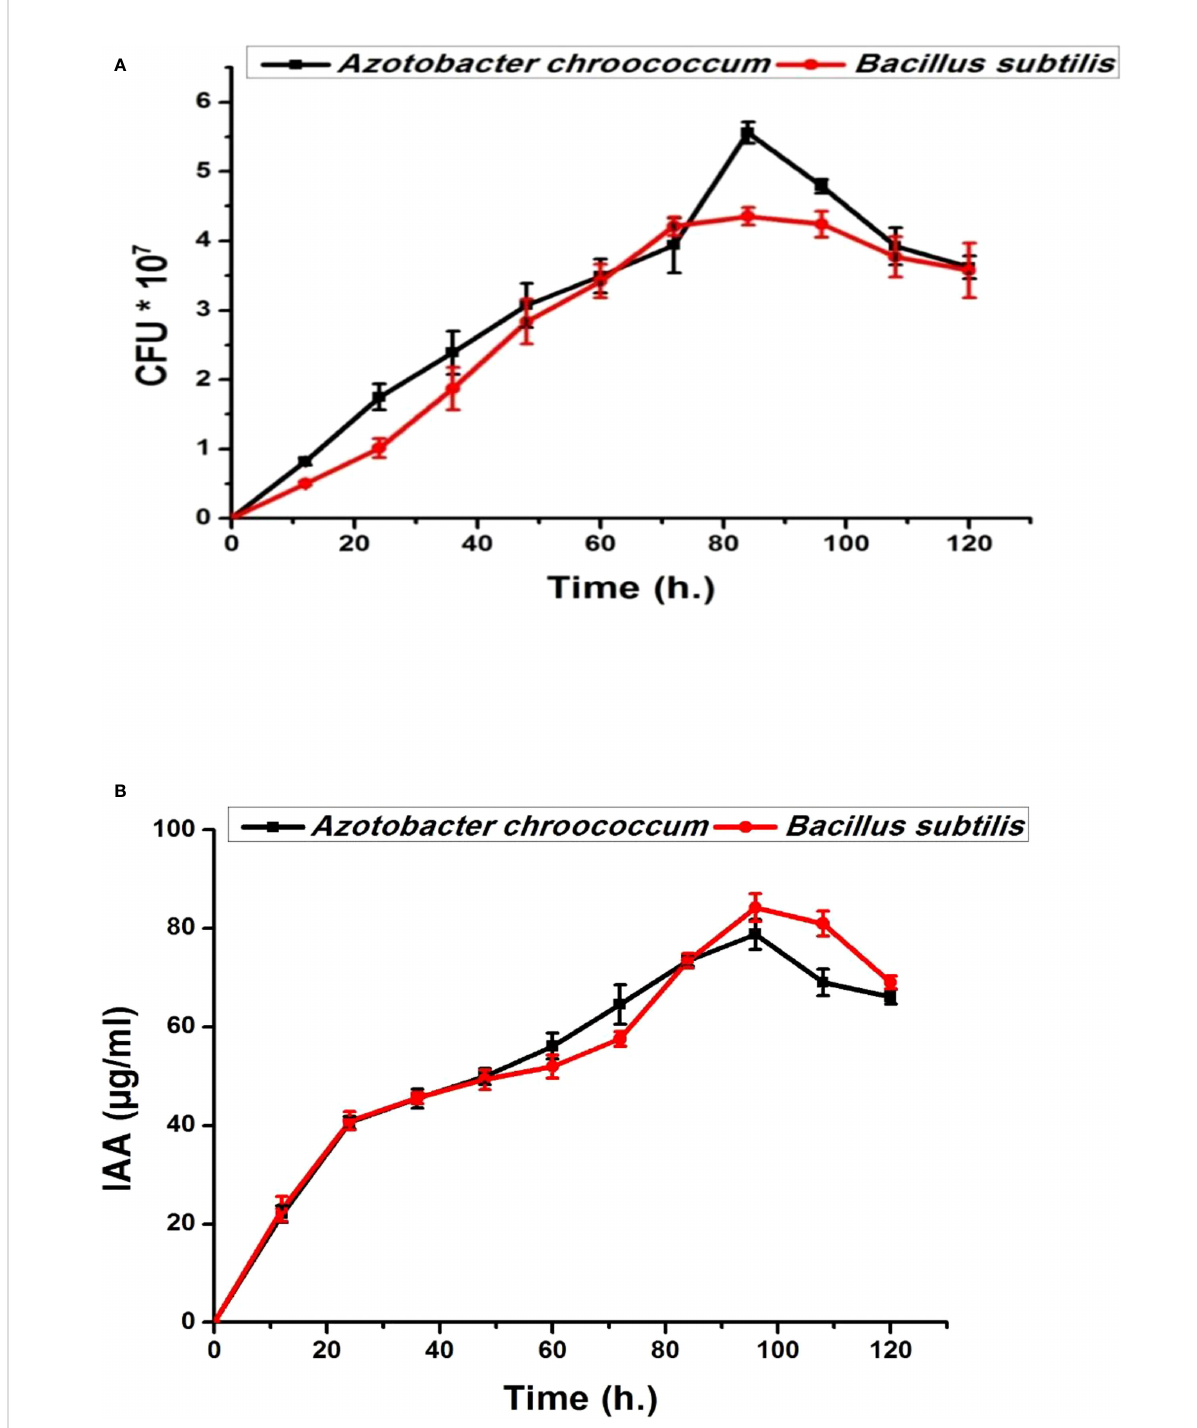
FIGURE 1 Bacterial growth curve (CFU × 10 7 ) (A) and indoleacetic acid (IAA) time course production (µg/ml) (B) of plant growth-promoting Azotobacter chroococcum and Bacillus subtilis on nutrient broth